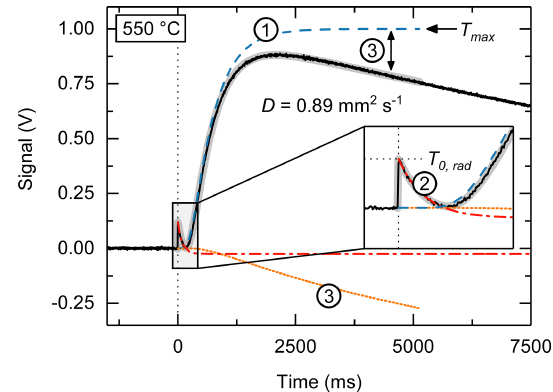
Figure 1. Signal–time curve (black line) measured at 550 ◦ C in the laser flash apparatus using the InSb infrared detector. The detector signal (V) is assumed to scale linearly to the temperature. The fitted curve (thick grey line) is the result of a least-squares approxima- tion of the adiabatic model by Parker et al. (1961) (1, dashed blue line) with a fast radiative portion (2, dash-dotted red line, Eq. 8, T ≤ 573 ◦ C) and subtracting heat loss from the specimen surface (3, dotted orange). The vertical dotted line denotes the release of the heating laser pulse. T 0 , rad corresponds to the direct radiative heat transfer at t = 0 . 0ms (Eq. 8). T max is referred to as the the- oretical adiabatic maximum temperature of the specimen rear side by lattice (phononic) heat transfer (i.e. excluding heat losses of the